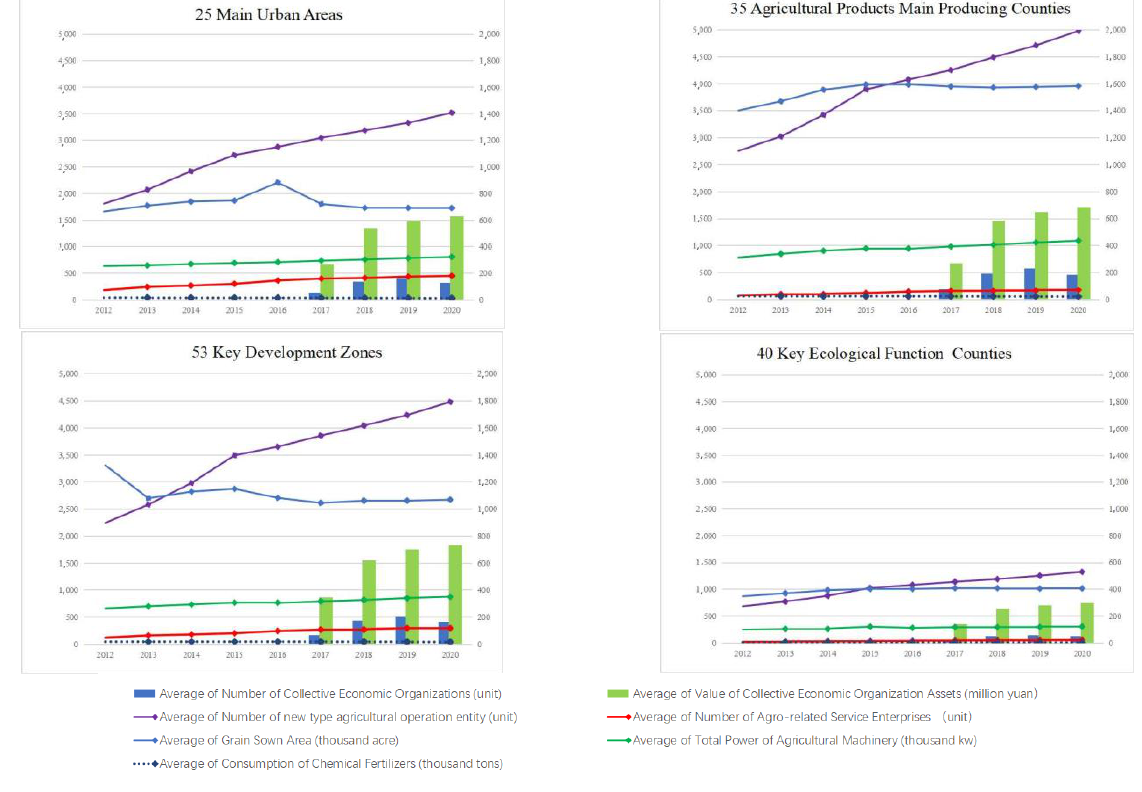
Figure 3. Trends of indicators before and after the reform of rural collective economic organizations in 4 categories of counties. Note: 1. Number of collective economic organisations, the value of collective economic organisations’ assets and the number of new types of agricultural operation entities are on the left axis. 2. Number of agro-related service enterprises, grain sown area, the total power of agricultural machinery and consumption of chemical fertilisers are on the right axis.